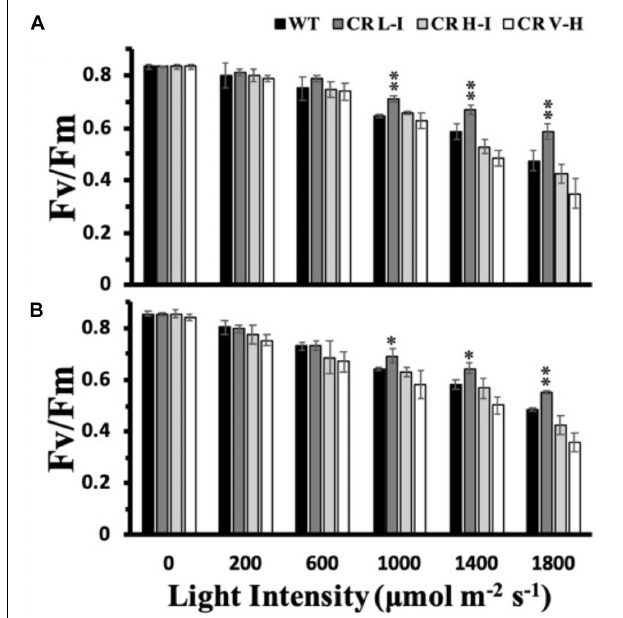
FIGURE 2 | Comparison of growth light intensity-dependent changes in Fv/Fm in wild-type and CAO RNAi transgenic lines. Wild-type (WT), CR L-I (Chl a/b = 4.5–6.5), CR H-I (Chl a/b = 6.5–8.5), and CR V-H (Chl a/b 8.5 or above) plants grown either in moderate light (ML) (850 µ mol photons m − 2 s − 1 ) (A) or in low light (LL) (200 µ mol photons m − 2 s − 1 ) (B) were exposed to light of various intensities for 3 h. All experiments were done using fully expanded leaves from the top of 4–5 weeks old plants. Before the measurement of Fv/Fm, leaves were dark-adapted for 30 min. Results represent the average and SD of three independent measurements. ∗ , values are significantly different at P < 0.05 and ∗∗ , values are significantly different at P < 0.01 between experimental